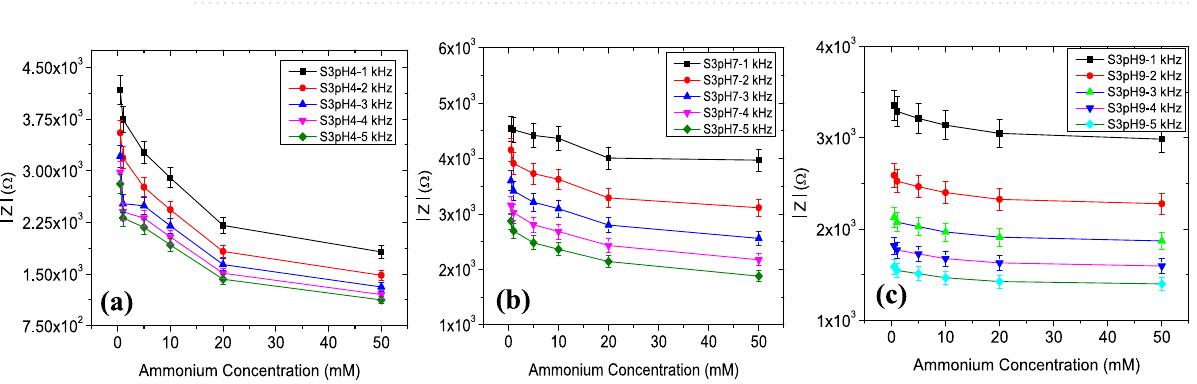
Figure 5. Impedance magnitude (Ω) versus NH 4 + ion concentration (0.5–50 mM) response of the sensor S2 in the ( a ) acid, ( b ) neutral and ( c ) alkaline sample conditions.